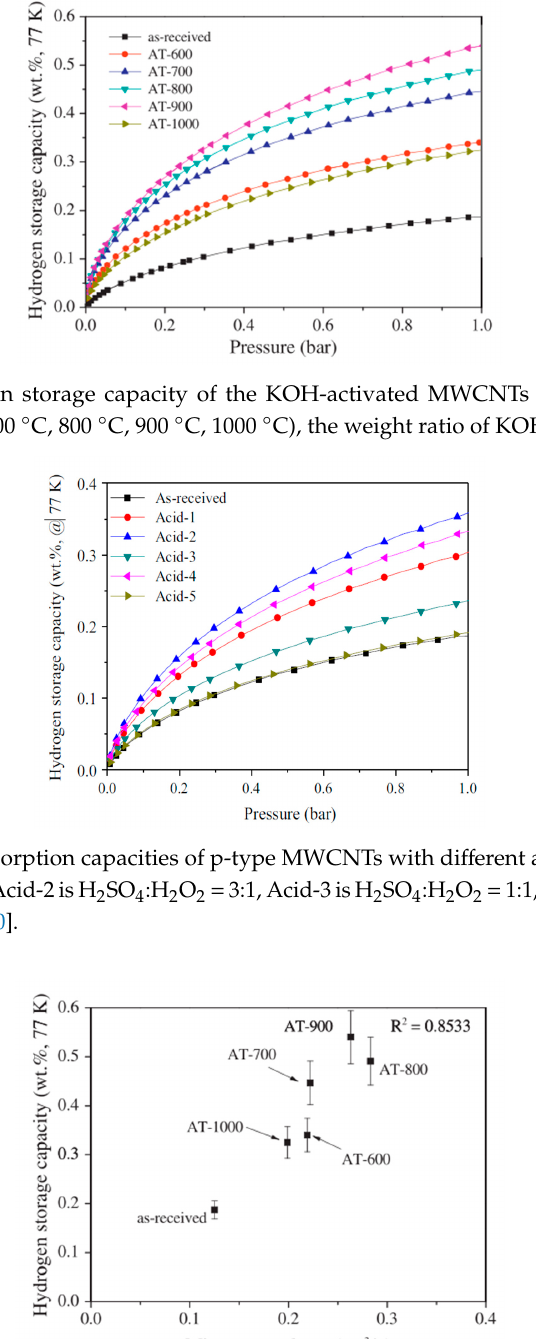
Figure 5. Relationship between the hydrogen adsorption capacity and micropore volume at different activation temperatures (600 °C, 700 °C, 800 °C, 900 °C, 1000 °C) [105] .